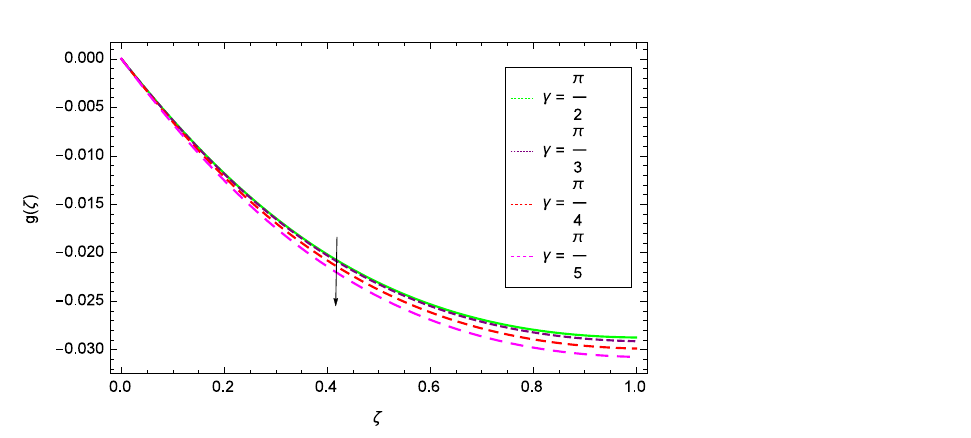
Figure 18. Parameter effect on velocity g ( ζ )